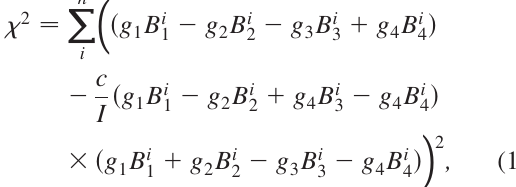
plot, the root mean square of the difference,